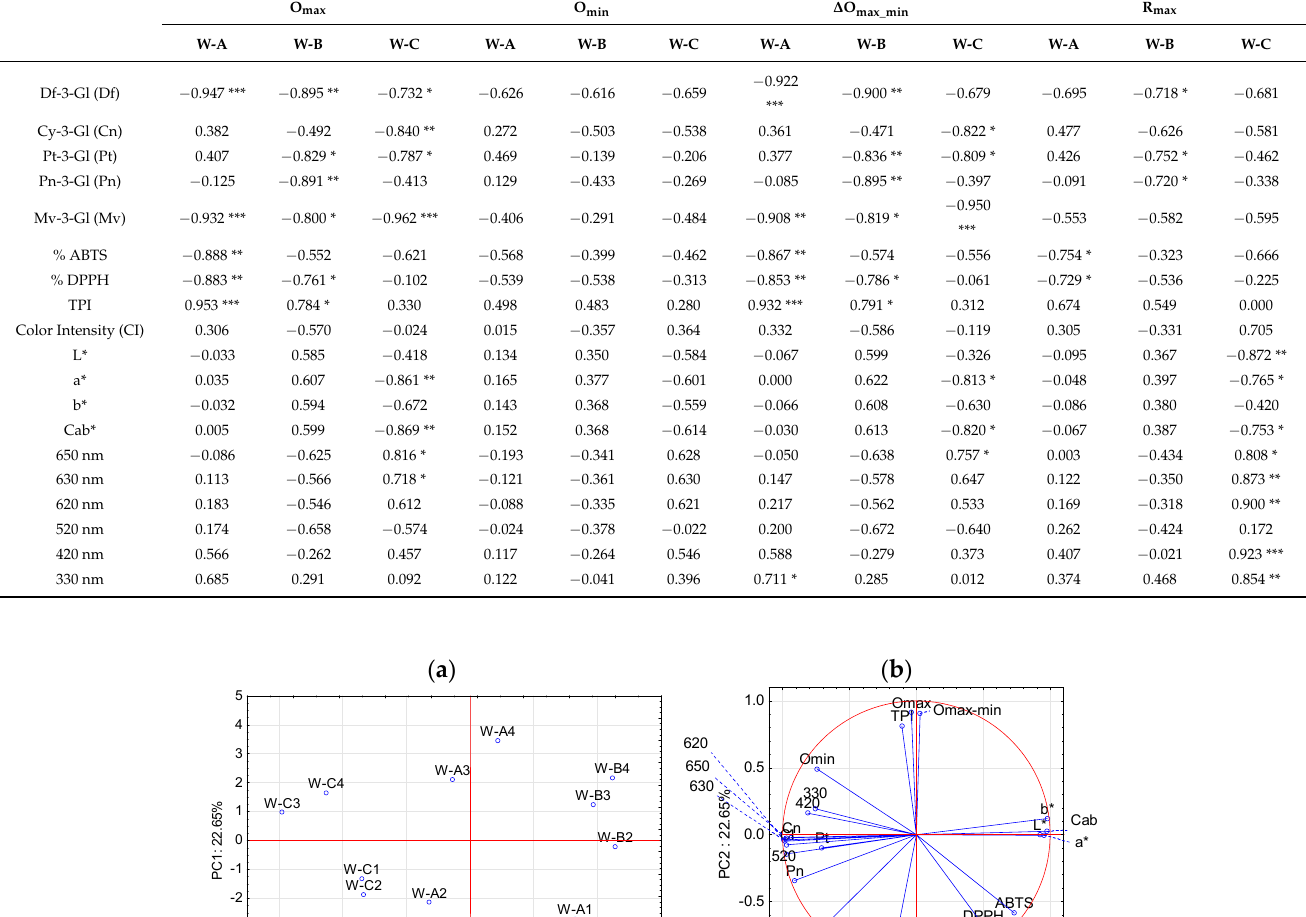
Table 2. Pearson correlation coefficients obtained between the consumption kinetics parame- ters and the difference between the chemical parameters obtained for W-A, W-B, and W-C after each saturation situation compared to the samples kept inert (* p level < 0.05, ** p level < 0.01, *** p level < 0.001). O min